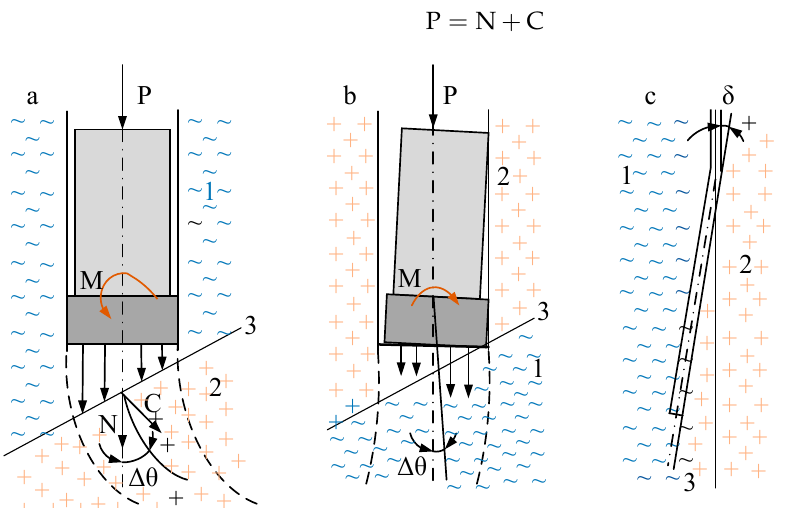
Figure 14. Borehole bending when the drill bit passes through the soft and hard interbedding. ( a )—Drill bit from soft rock to hard rock; ( b )—Drill bit from hard rock to soft rock; ( c )—The slid- ing condition of the drilling tool when the formation angle is small. 1—Soft rock; 2—Hard rock; 3—Contact surface of soft and hard interlayer.